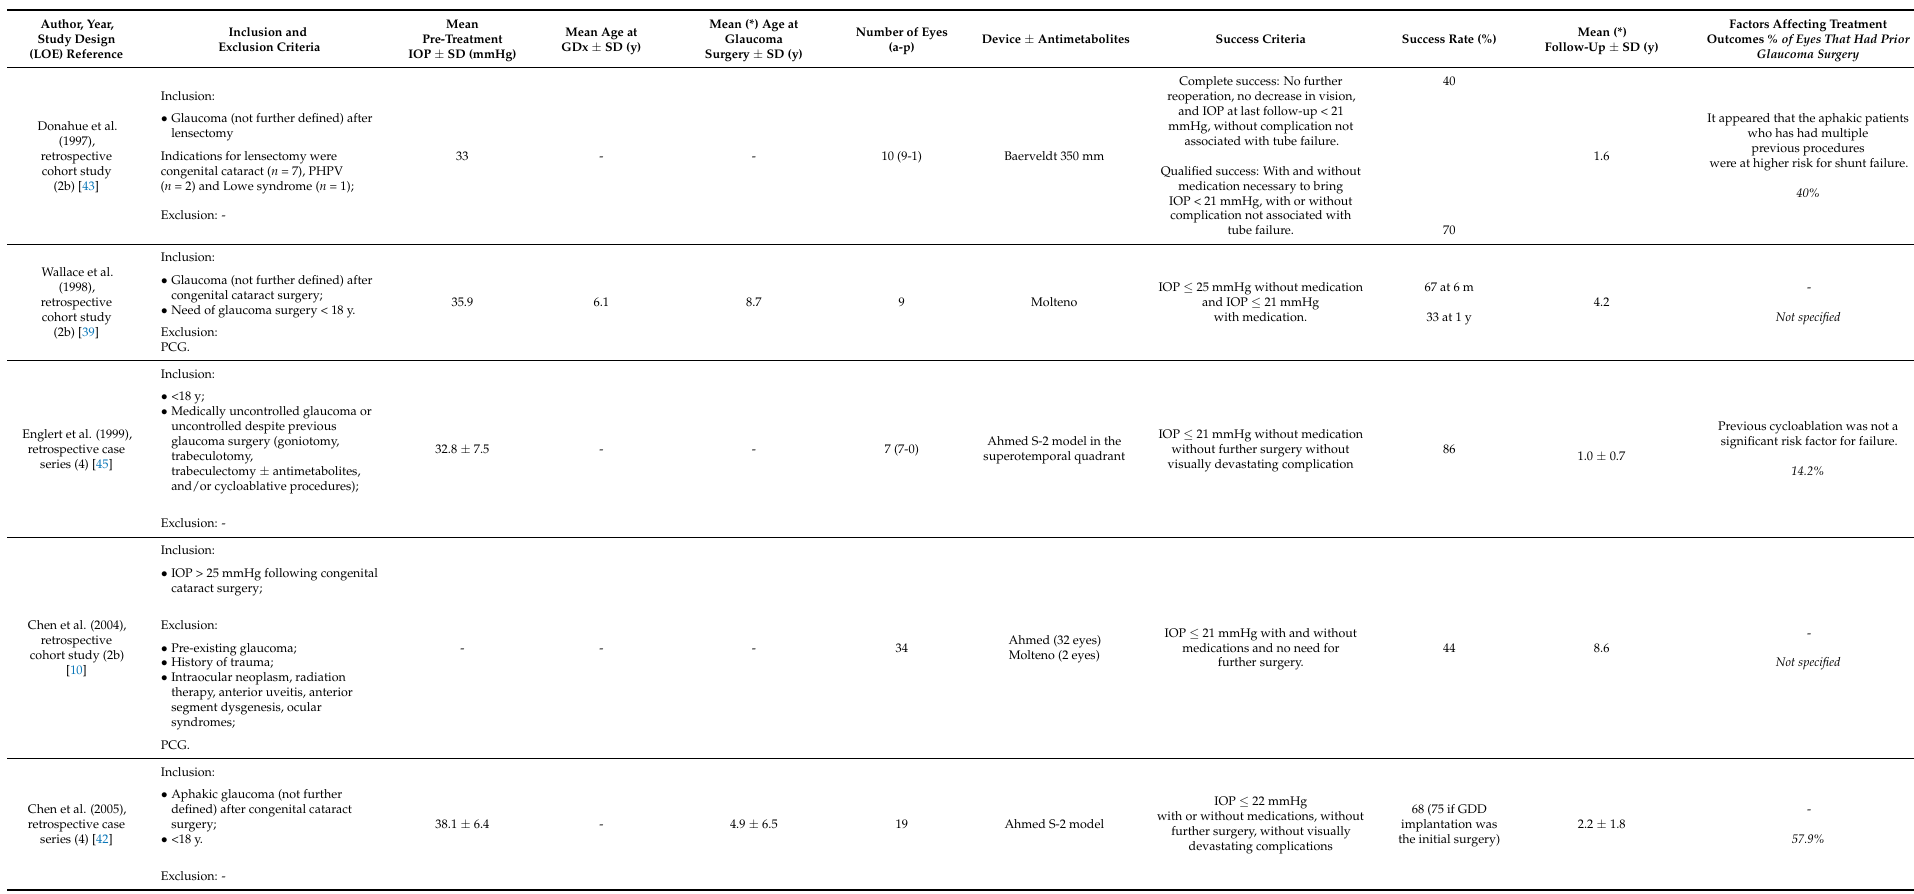
Table 4. Relevant studies involving glaucoma drainage device implantation in GFCS